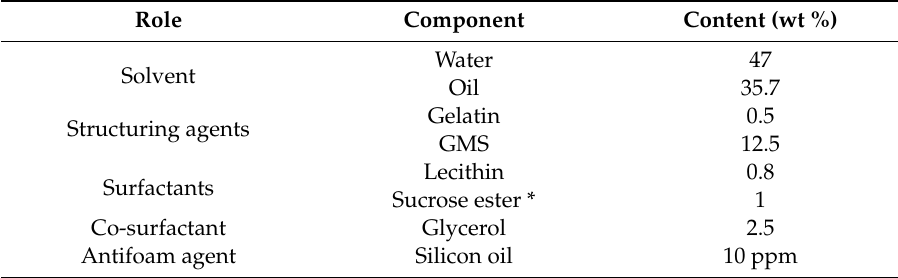
Table 1. Formulation composition of the di ff erent bigel